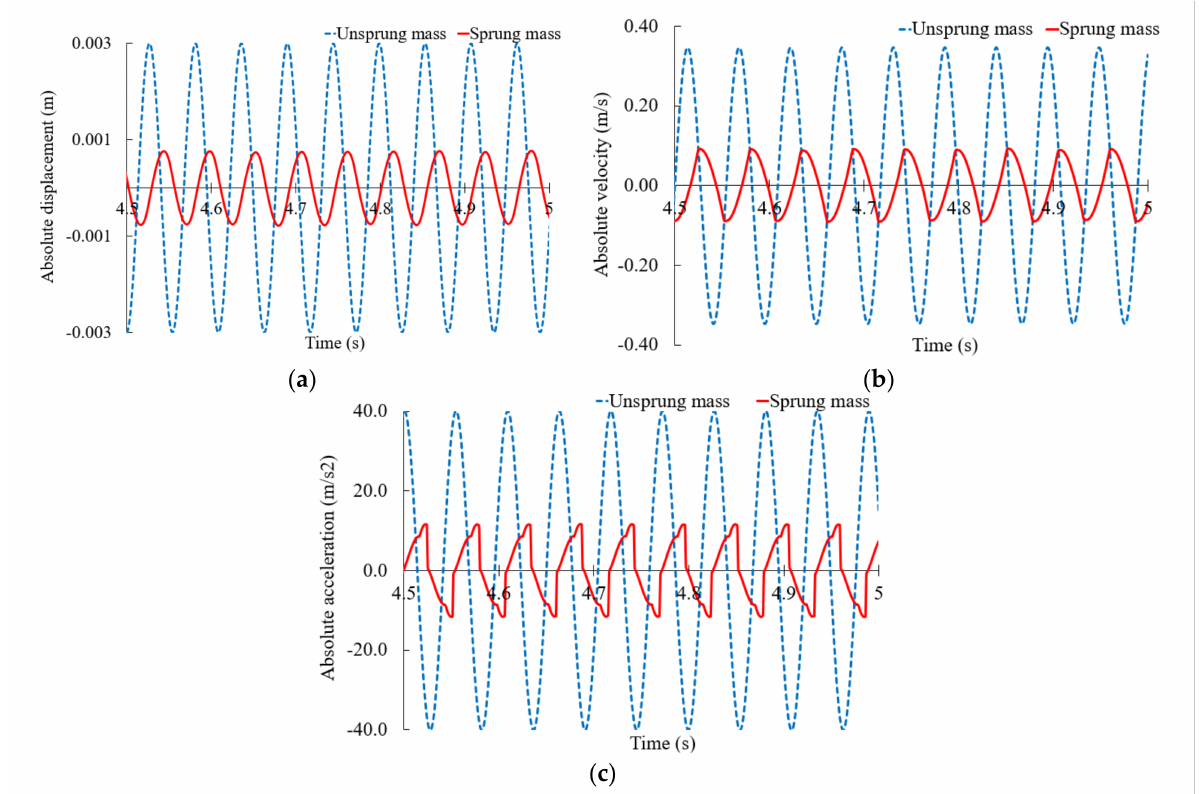
Figure 10. Response of the time domain of ( a ) displacement, ( b ) velocity, and ( c ) acceleration of the sprung and un-sprung mass with the excitation frequency equal to 2-fold the natural